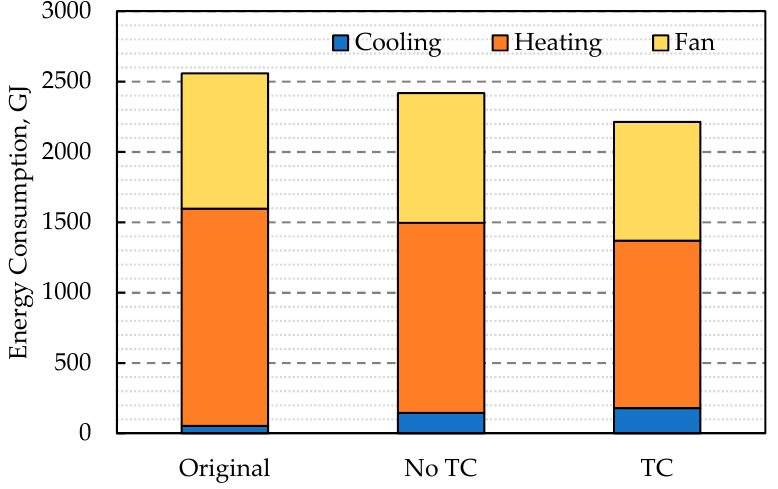
Figure 7. Optical properties of the thermochromic windows [17]